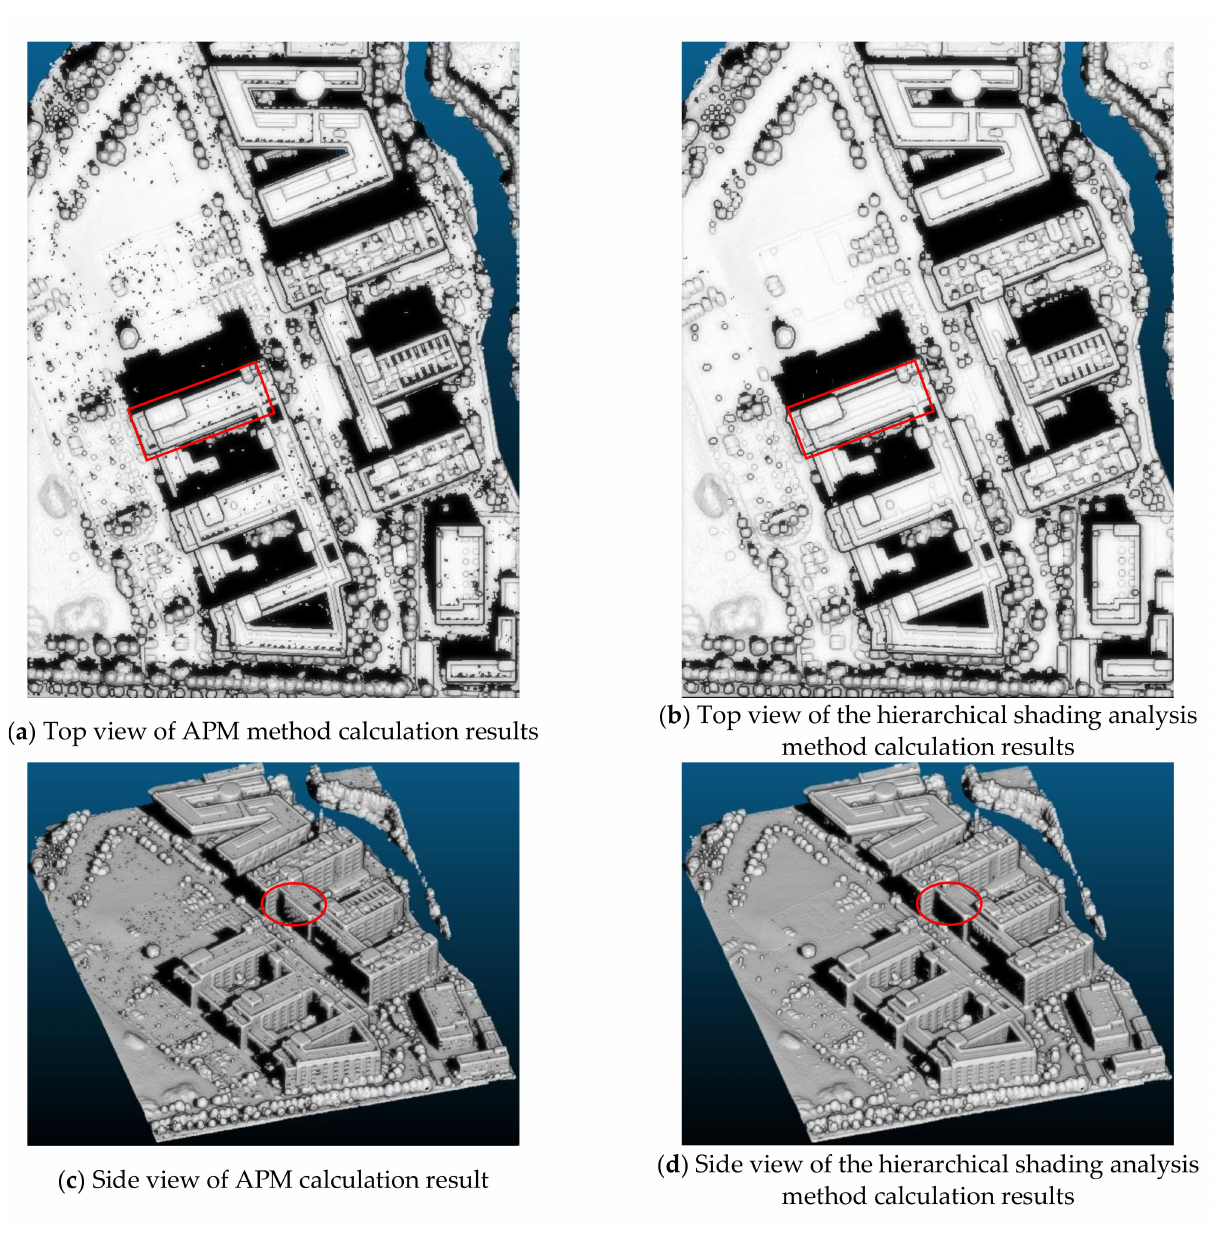
Figure 12. Comparison of shadow simulation results with other